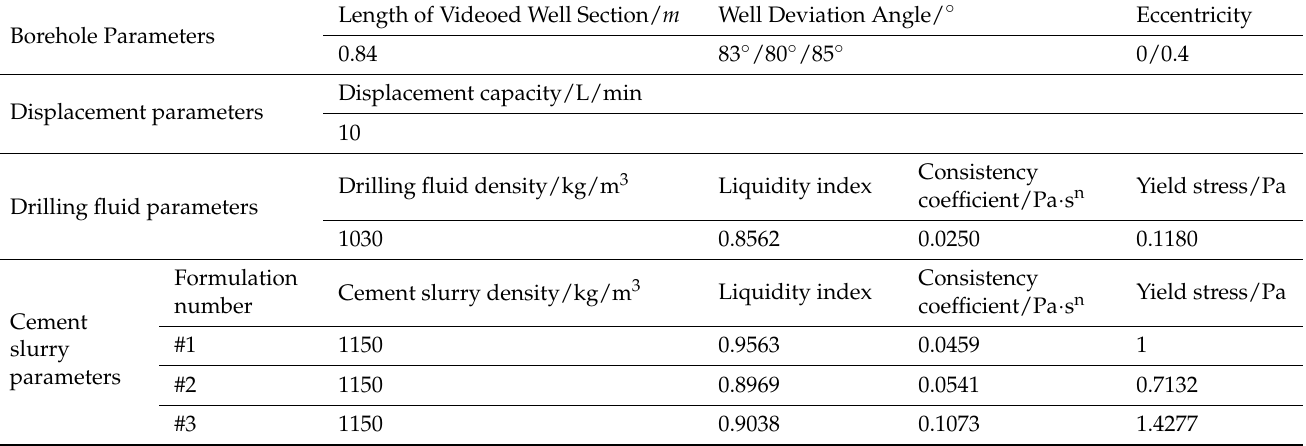
Table 1. The basic parameters of the cementing displacement